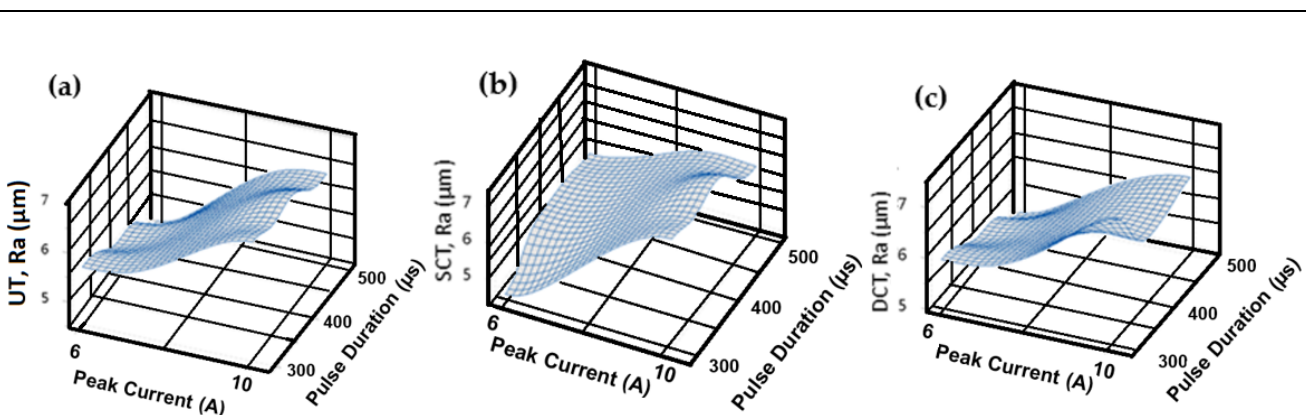
Figure 3. Graphs of average surface roughness variations in materials: ( a ) UT, ( b ) SCT and ( c ) DCT.